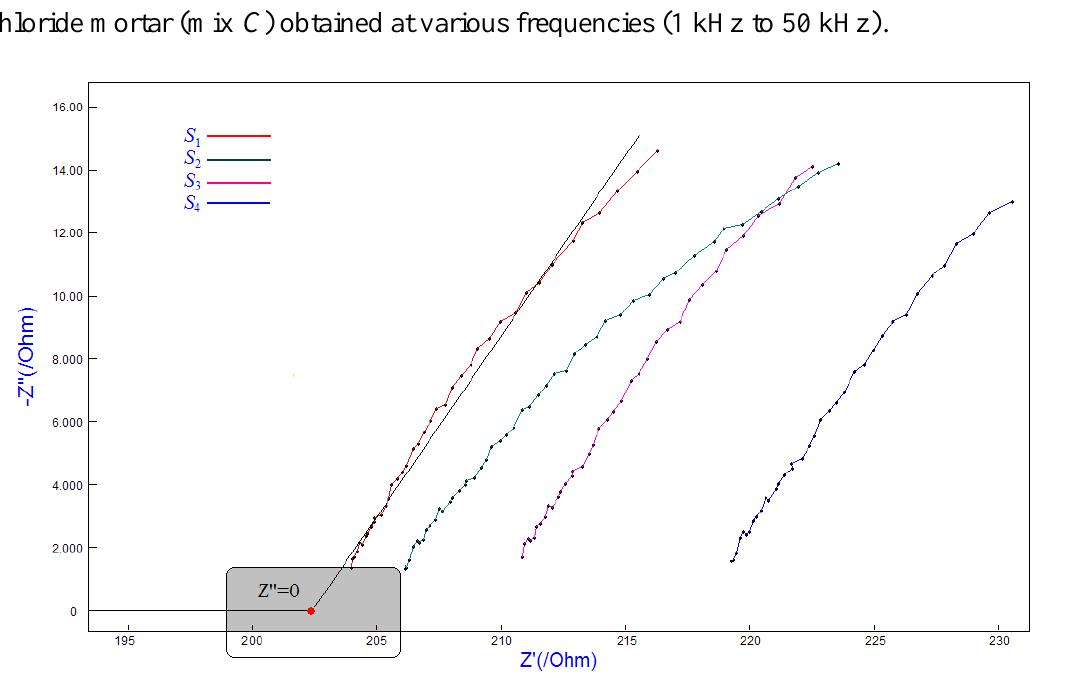
Figure 3. Nyquist plots of Z′ versus Z″ for the sensor system embedded in 3% sodium chloride mortar (mix C ) obtained at various frequencies (1 kHz to 50